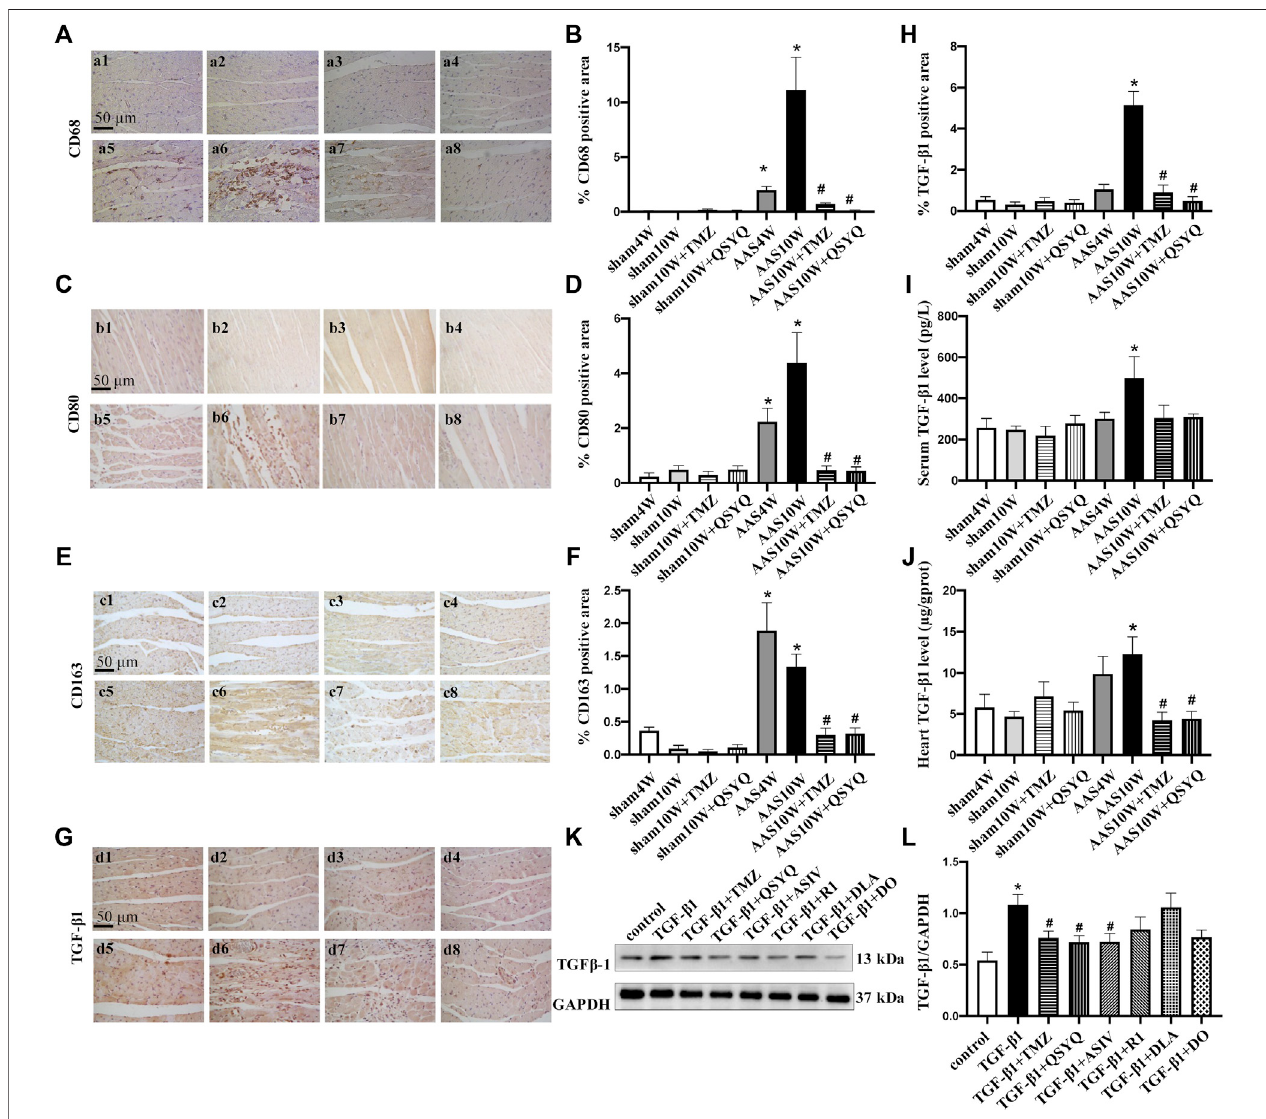
FIGURE 4 | QSYQ inhibited monocyte in fi ltration, macrophage polarization and TGF- β 1 expression. The four panels on the left show the immunohistochemistry stainingresultsforCD68 (A,B) ,CD80 (C,D) ,CD163 (E,F) ,andTGF- β 1 (G,H) intheSham4W(a1,b1,c1,andd1),Sham10W(a2,b2,c2,andd2),Sham10W+TMZ(a3, b3,c3,andd3),Sham10W+QSYQ(a4,b4,c4,andd4),AAS4W(a5,b5,c5,andd5),AAS10W(a6,b6,c6,andd6),AAS10W+TMZ(a7,b7,c7,andd7),andAAS10W +QSYQ(a8,b8,c8,andd8)groupsinmyocardiumanditsquanti fi cationanalysisresults,respectively.Bar=50 μ m.Dataarepresentedasthemean±SEM, n =6. (I) Serum TGF- β 1level detected byELISA. (J) TGF- β 1level inrat myocardial tissue detectedbyELISA. Dataarepresentedasthe mean± SEM, n =4. (K,L) Proteinlevel of TGF- β 1 in Raw264.7 cells detected using Western blot. Data are presented as the mean ± SEM, n = 4. * p < 0.05 vs. sham or control; # p < 0.05 vs. AAS or RP S19.